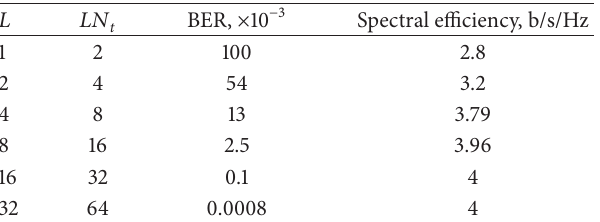
Table 1: BER and spectral efficiency of RSTBC in massive SU- MIMO with 16-QAM at SNR = 4dB and loss rate =